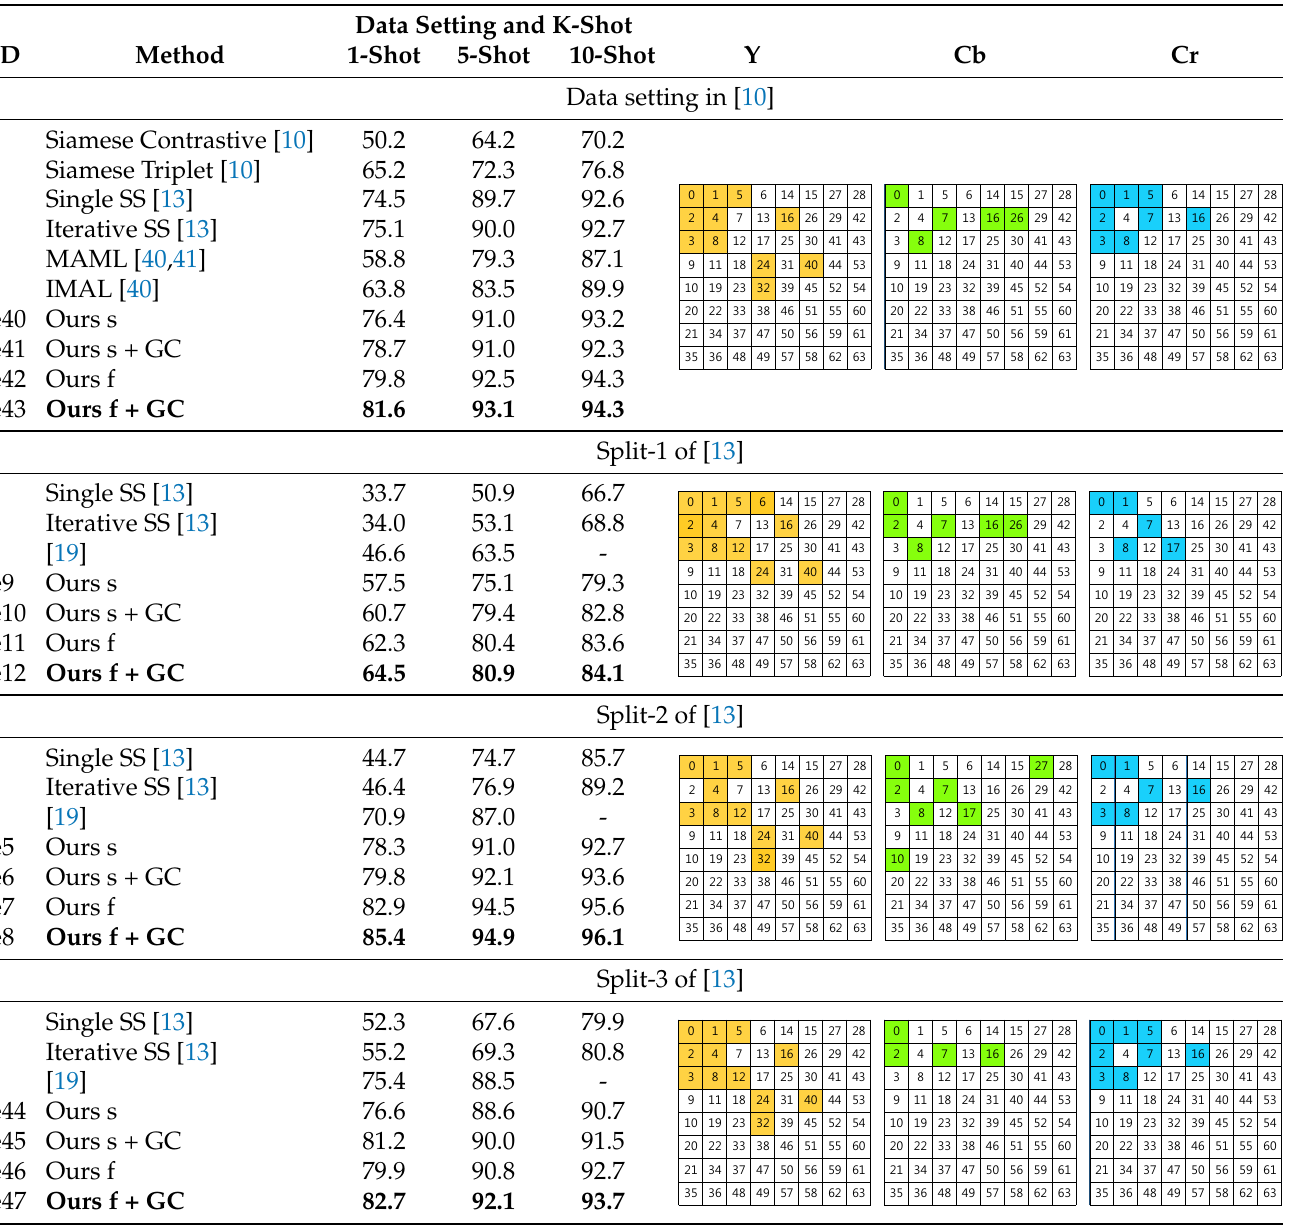
Table 9. The results compared with related